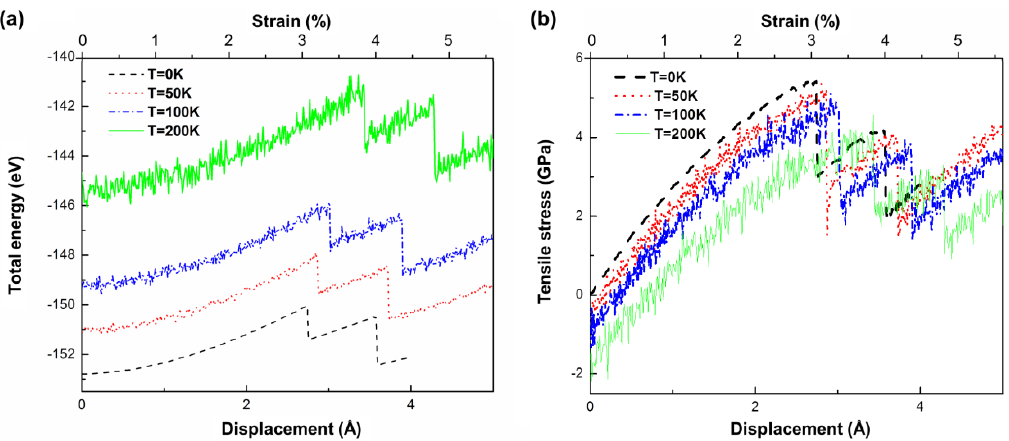
Figure 2. ( a ) Plots of total energy vs. displacement. ( b ) Plots of tensile stress vs. displacement at different temperatures.